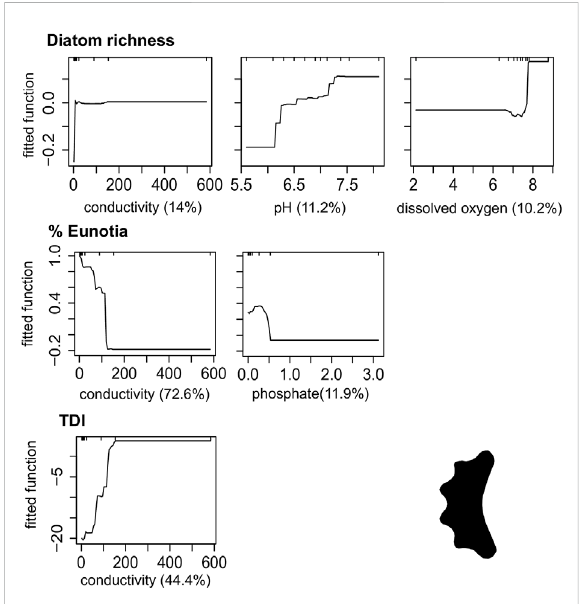
FIGURE 5 Boosted regression tree (BRT) fi tted functions for the best performance models of Diatom metrics. Plots are only shown for those predictors that explained more than 10% deviance in the metric. Rug plots show the distribution of data, in deciles, of the variable on the X-axis. (TDI) Trophic Diatom